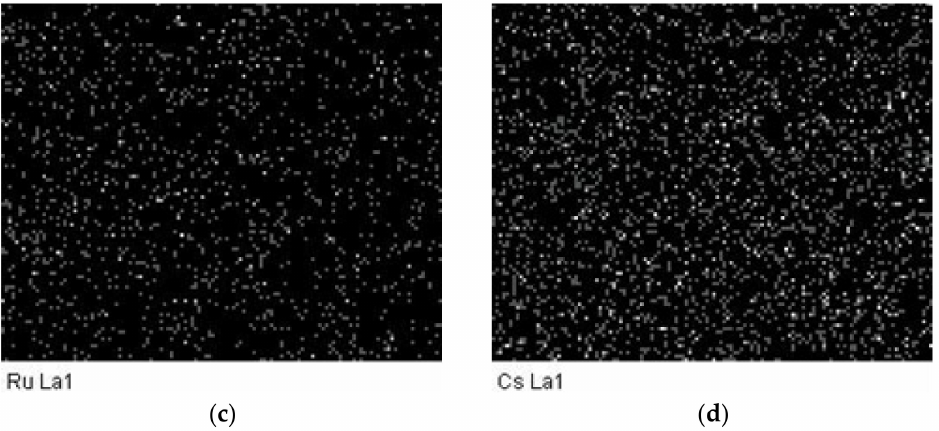
Figure 1. The SEM image and maps of elements for the overall molar ratio of Cs/Ru = 4, ( a ) SEM image, ( b ) map of element C, ( c ) map of element Ru, and ( d ) map of element Cs.